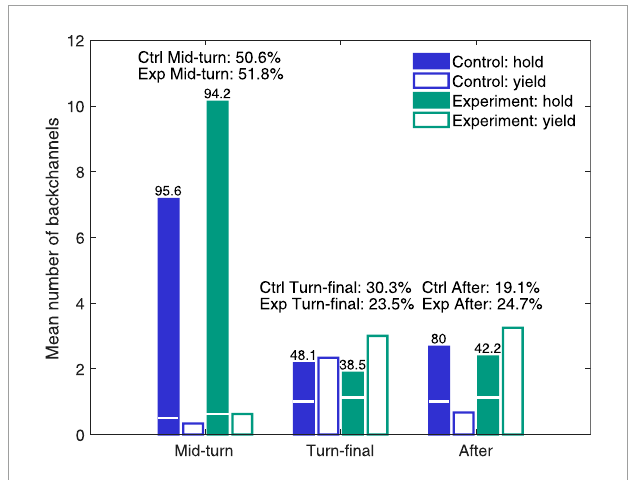
FIGURE 4 Mean number and percentage of speaker holding and yielding turn depending on backchannel timing. Numbers on top of Hold bars are the percentage of Hold vs. Yield for the different timings. The horizontal white line in the Hold bars indicate the mean number of speaker utterances that were preceded by a hesitation or pause (below line). The distribution between the different backchannel timings is given above the corresponding bar